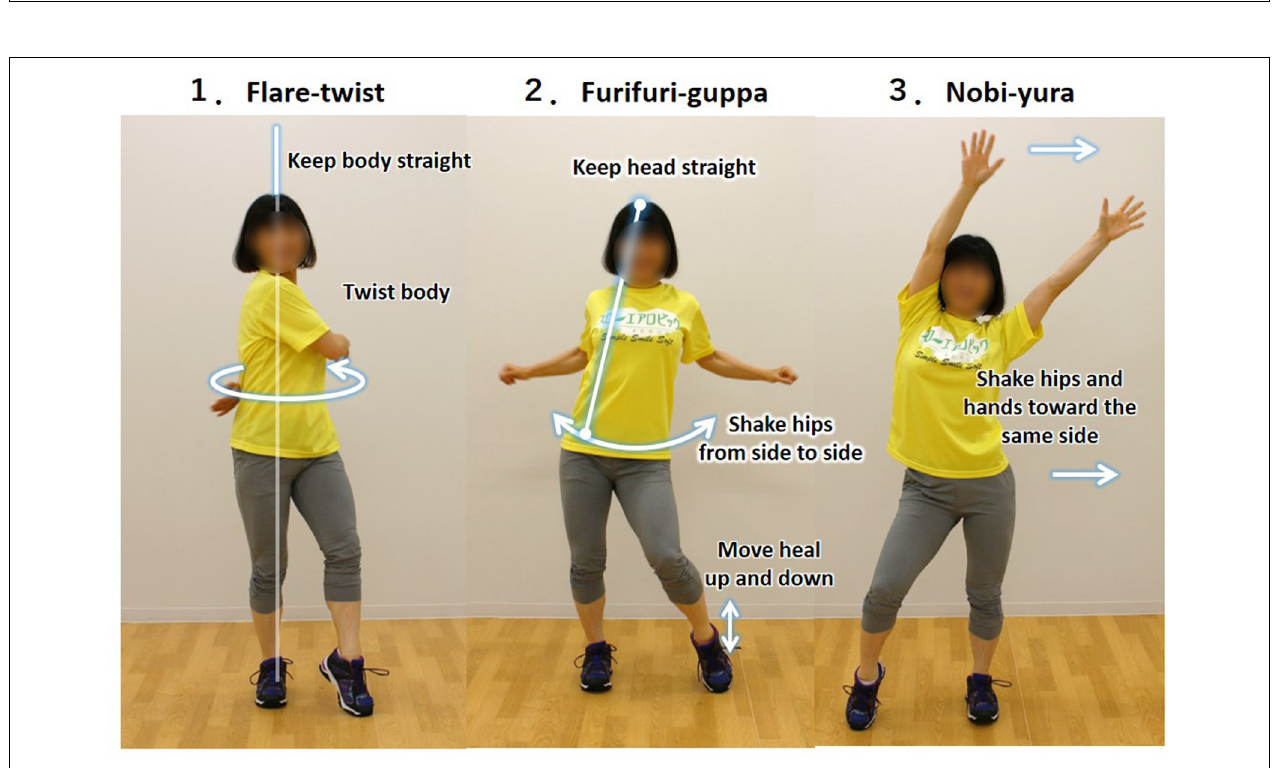
FIGURE 2 | Three components of the “Slow Aerobic Dance Exercise”.